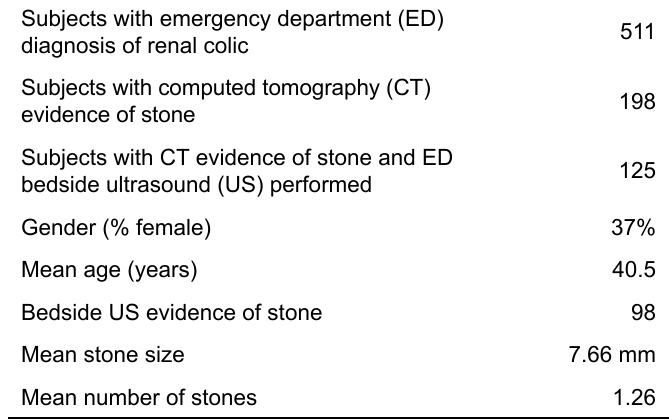
Table 5. Sensitivity of either hematuria or ultrasound by stone